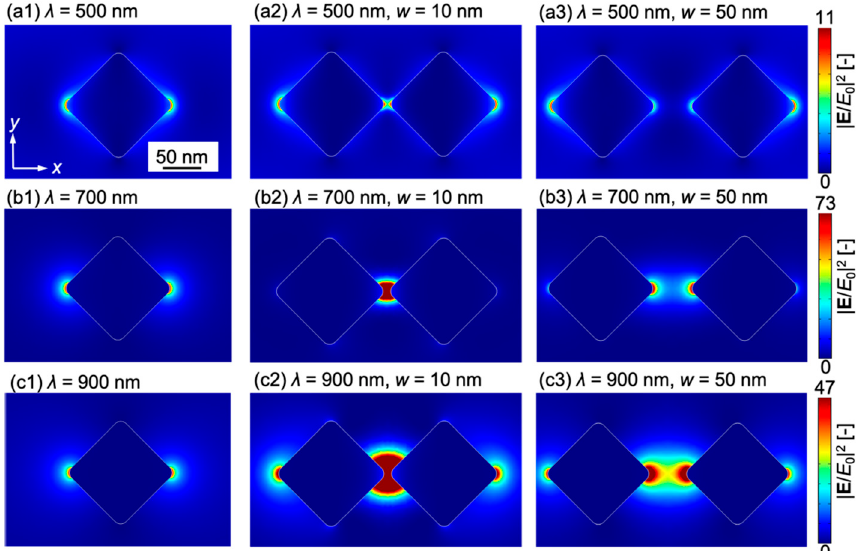
Figure 5. Electric field intensity | E /E 0 | 2 in the xy cross section at the center of the structure: ( a1 ) A gold nanostructure at wavelength λ = 500 nm, ( a2 ) two gold nanostructures at λ = 500 nm, w = 10 nm and ( a3 ) λ = 500 nm, w = 50 nm; ( b1 ) A gold nanostructure at λ = 700 nm, ( b2 ) two gold nanostructures at λ = 700 nm, w = 10 nm and ( b3 ) λ = 700 nm, w = 50 nm; ( c1 ) A gold nanostructure at λ = 900 nm, ( c2 ) two gold nanostructures at λ = 900 nm, w = 10 nm and ( c3 ) λ = 900 nm, w = 50 nm.